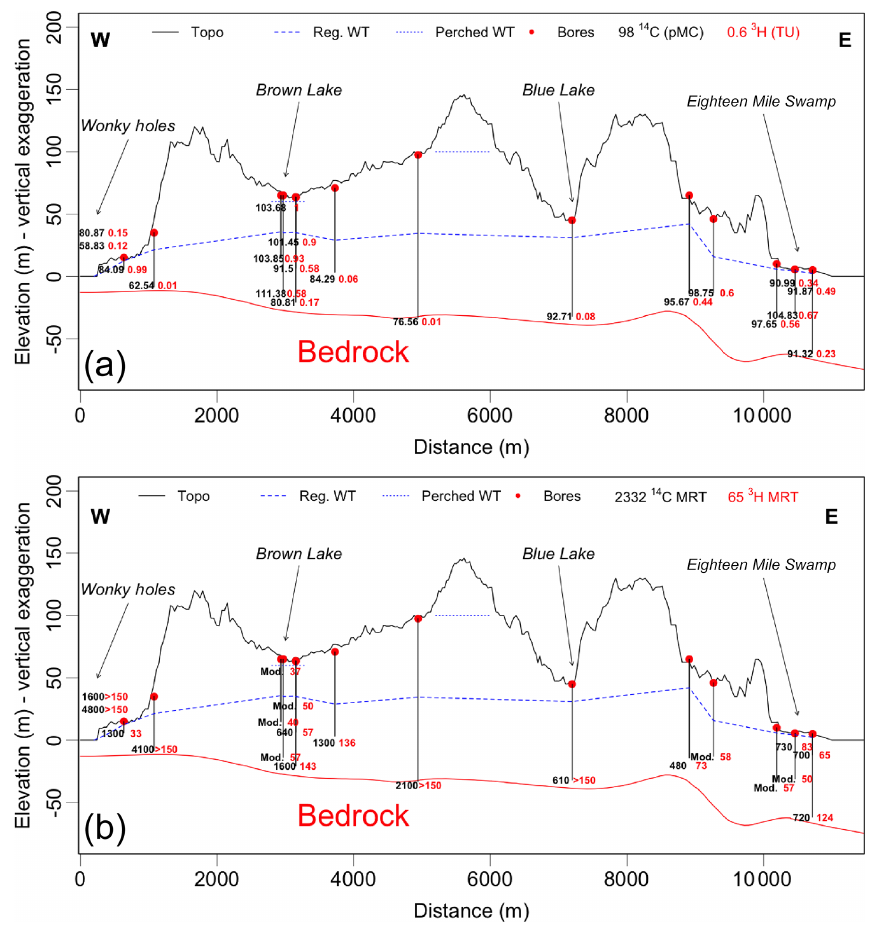
Figure 8. (a) Vertically exaggerated cross section along the sample transect with bore locations, depth, pMC (black), and tritium activities (red). (b) Estimated MRTs calculated for tritium activities (rainfall 1.6TU) with an exponential piston flow model, and 14 C ages after correction ( q = 0 .